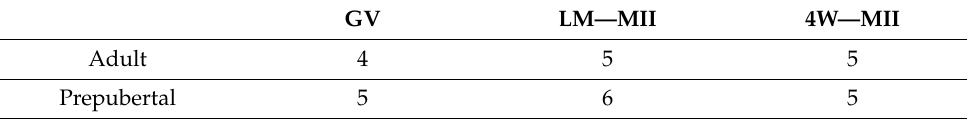
Table 1. Number of pools of ten oocytes used for gene expression analysis. GV LM—MII